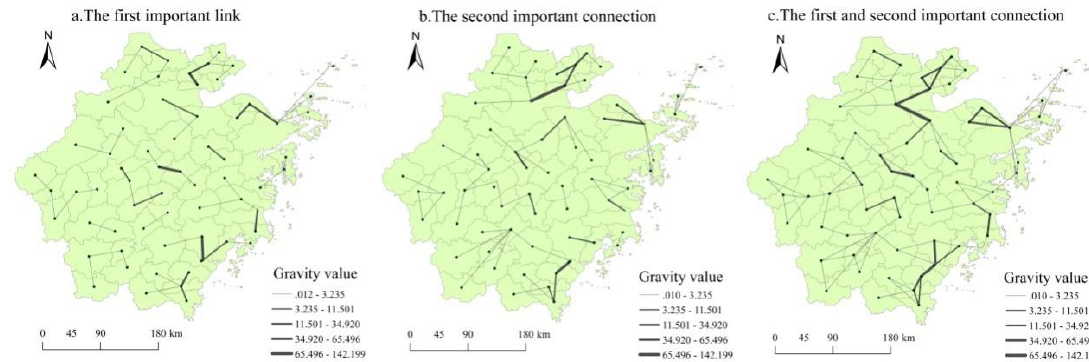
Figure 3. Main direction of the e-retail economic links at the county level in Zhejiang Province.